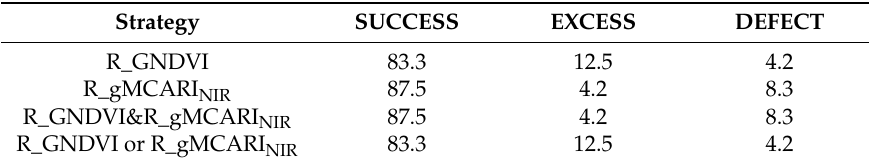
Table 5. Percentage of success and failure by excess and defect using the indices GNDVI, gMCARI NIR and the combinations GNDVI & gMCARI NIR and GNDVI or gMCARI NIR (25% data, excluded plots with R_yield below 0.7, total number of plots used for validation: 24). Strategy